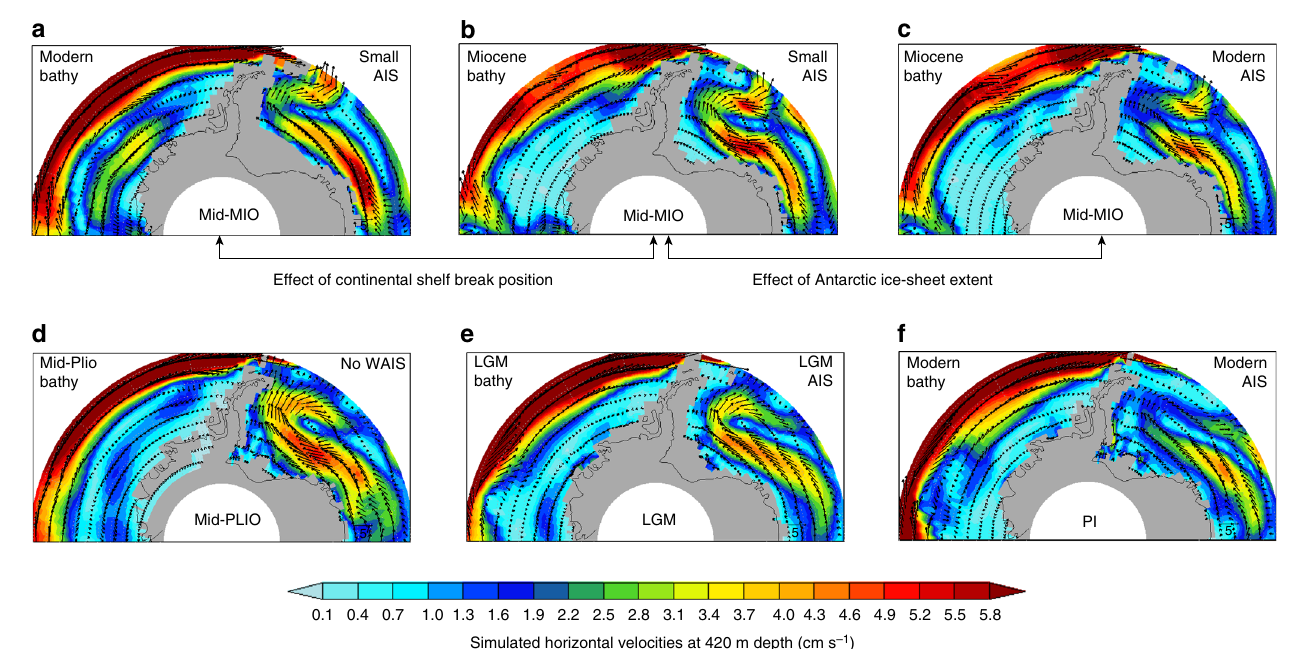
Fig. 5 Impact of extent and location of the continental shelf break on ocean circulation for different mean climate states. Simulated ocean horizontal velocities (cm s − 1 ) at a depth of 420 m (averaged core depth of CDW) for: a mid Miocene (mid-MIO) 89 , for modern continental shelf break location, small AIS extent and atmospheric CO 2 concentration of 450 ppm representing 17 – 15 Ma 73 . b Same as for a , but with a smaller continental shelf break 63 than in a . c Same as for b , but with modern AIS extent and atmospheric CO 2 concentration of 278 p.p.m. representing 14 – 12 Ma. Comparison between a and b gives the impact of the continental shelf extent and location, whereas comparison between a and c shows the impact of AIS extent (and CO 2 concentration, which is of minor importance). Bottom row: simulated mean ocean states for key periods of the Plio/Pleistocene. d Mid-Pliocene simulation (mid-PLIO, ≈ 3 Ma) with Pliocene bathymetry, an almost ice-free West AIS and atmospheric CO 2 concentration of 405 p.p.m. 119 . e LGM ( ≈ 21 ka) with LGM bathymetry, LGM AIS extent and atmospheric CO 2 concentration of 185 p.p.m. 120 . f Pre-industrial simulation (PI) with modern bathymetry and AIS extent, and with atmospheric CO 2 concentration of 278 p.p.m. 119 . The fi nal 100 years of simulation of each model experiment is taken for analysis and outputs are available for download on the PANGEA database at